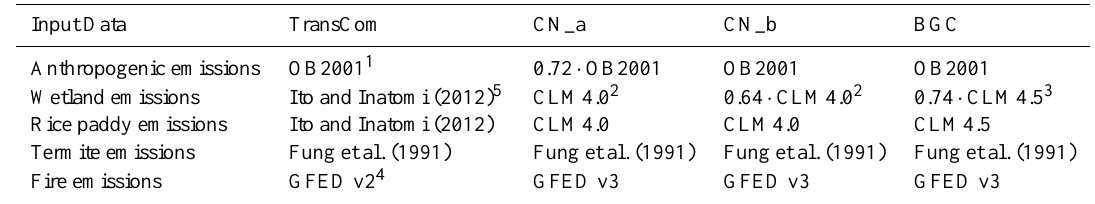
Table 1. Comparison of the methane sources in the four simulations used in this study.